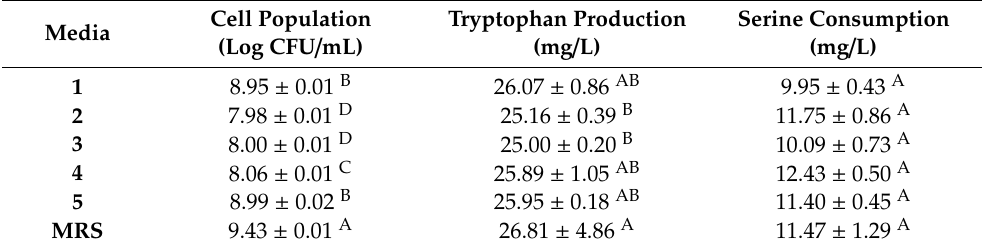
Table 4. Growth, net tryptophan and serine produced by P. acidilactici TP-6 in formulated